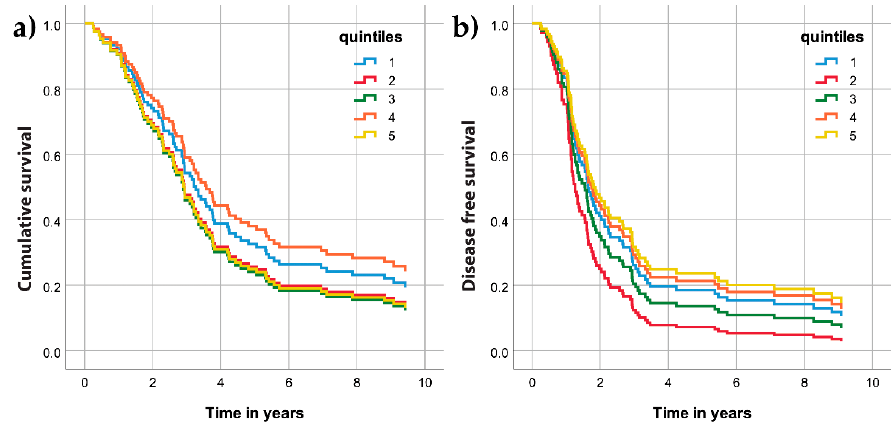
Figure 7. Cumulative survival ( a ) and disease-free survival ( b ) curves for the AKR1C3 quintile groups of patients with high-grade ovarian cancer.